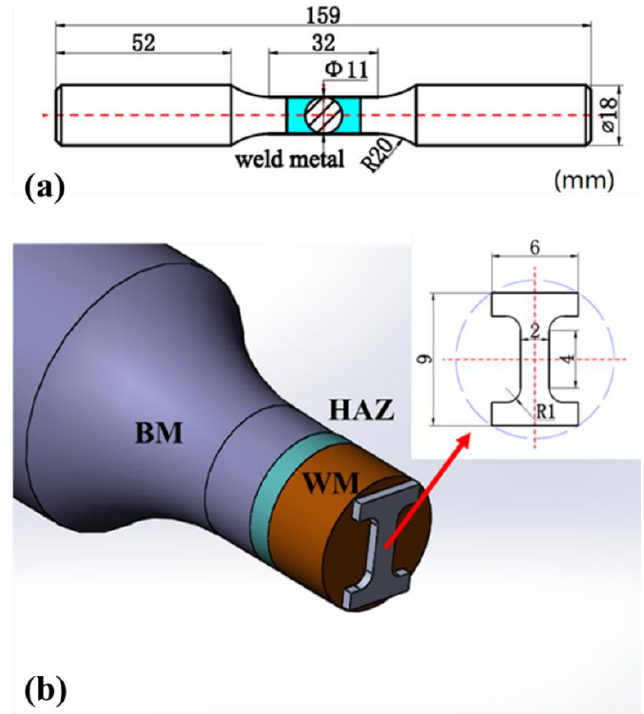
Figure 2. The detailed sizes of the specimens used in the low-cycle fatigue tests ( a ) and the detailed sizes of the miniature specimens used in the tensile tests ( b ).